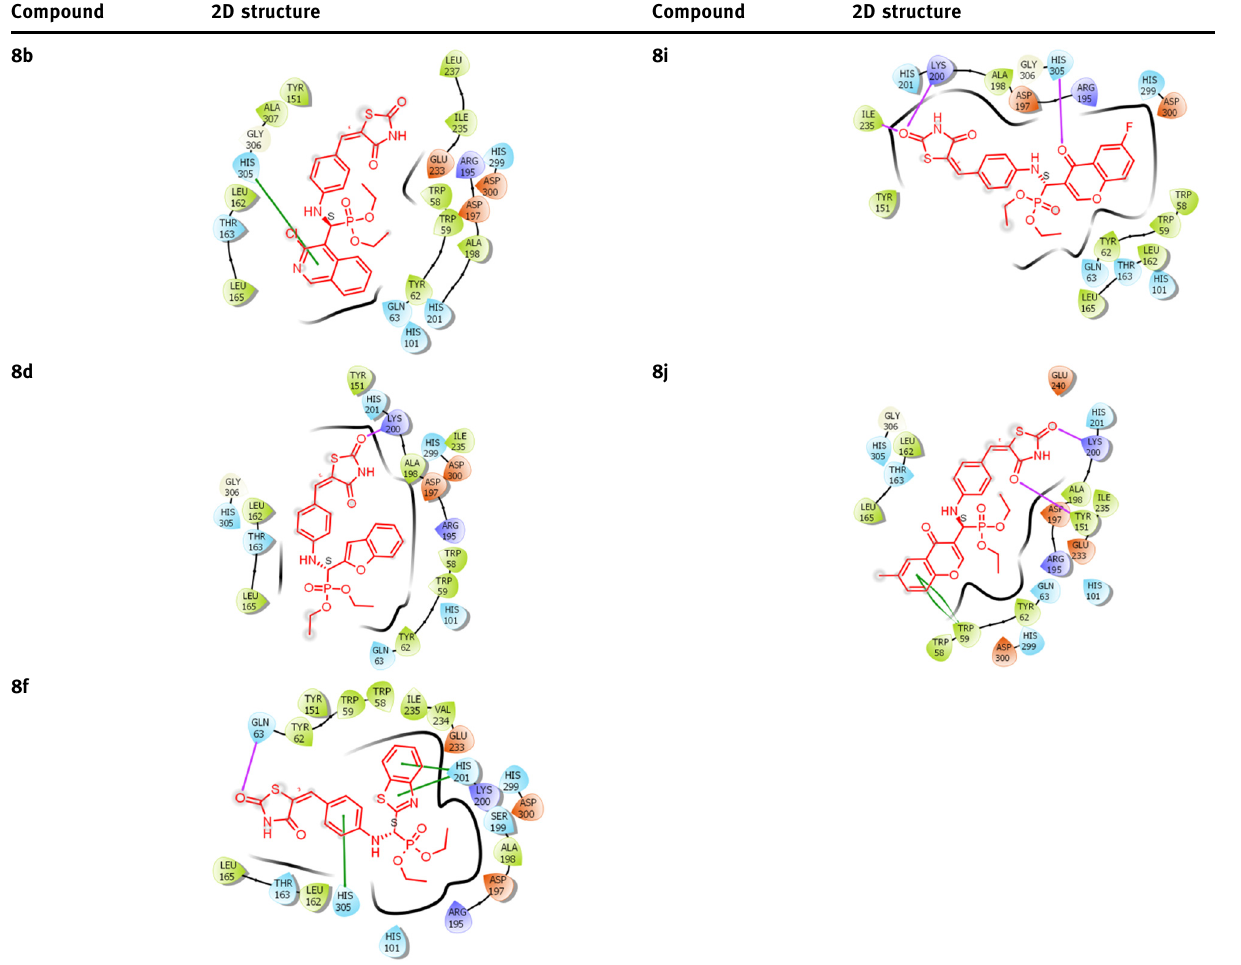
Table 8: 2D LIGPLOT images of compounds 8b, 8d, 8e, 8i , and 8j